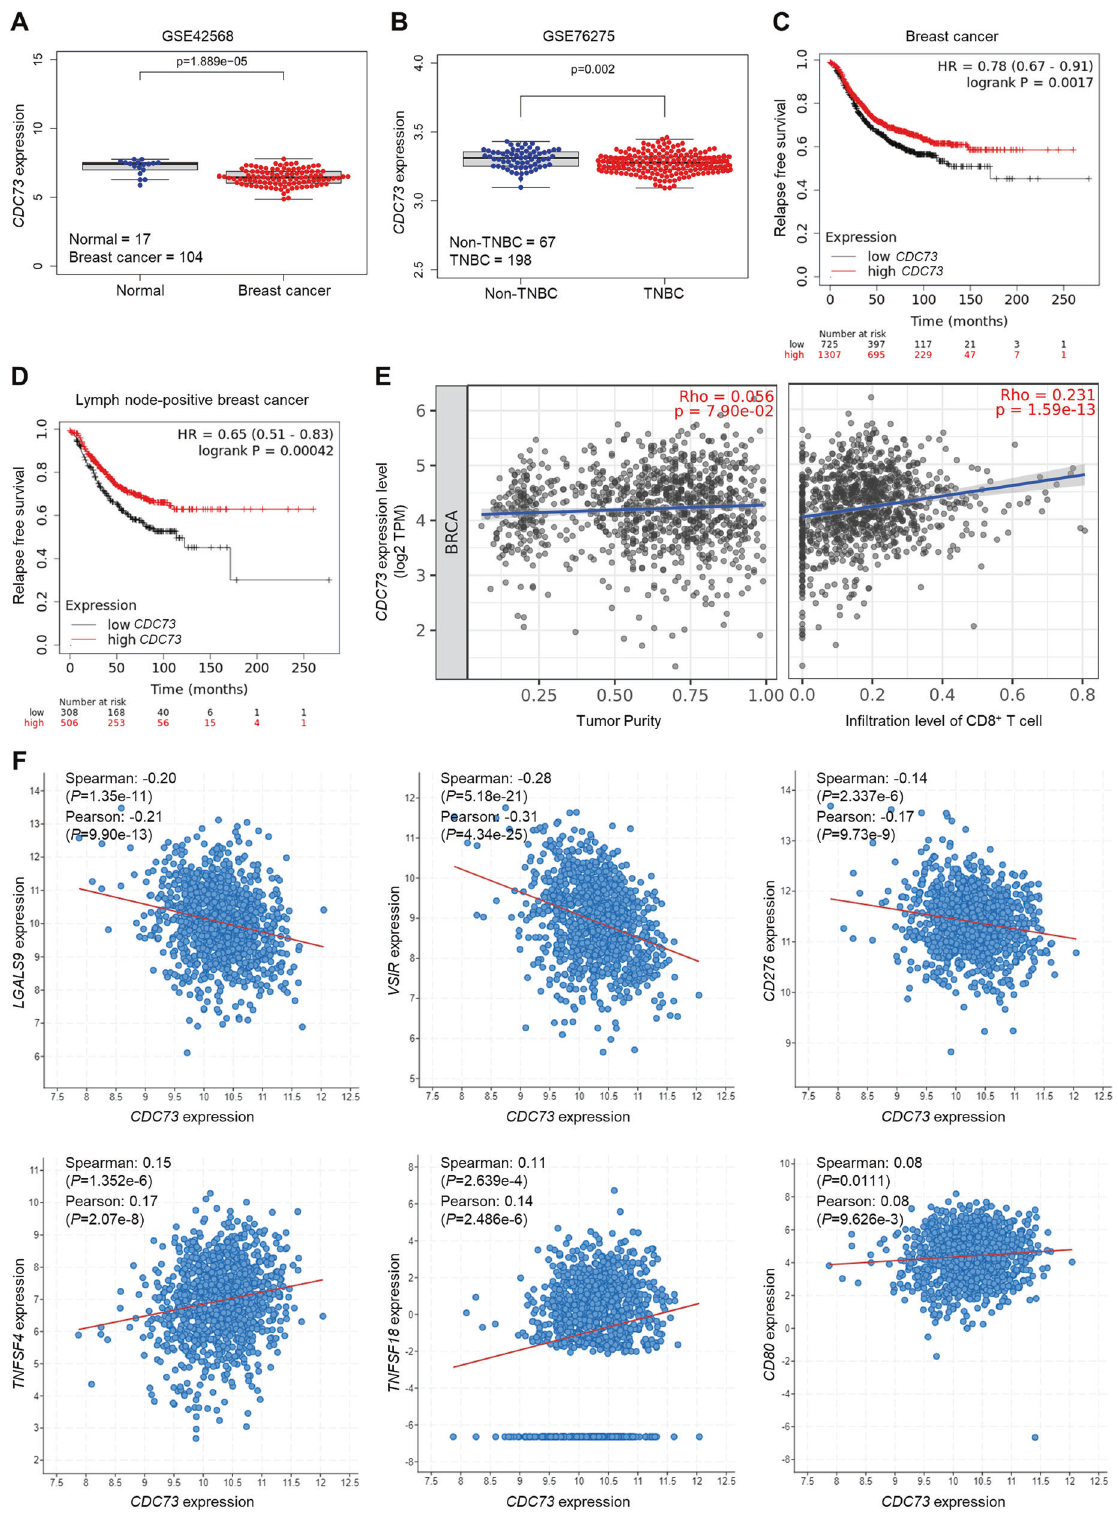
Fig. 1 Expression of CDC73 negatively correlates with human breast cancer progression. A The mRNA level of CDC73 in patient normal breast tissue ( n = 17) and breast cancer tissue ( n = 104) from the subset GSE42568. B The mRNA level of CDC73 in patient Non-TNBC tissue ( n = 67) and TNBC tissue ( n = 198) from the subset GSE76275. Correlations of CDC73 expression with relapse free survival of breast cancer patients ( n = 2032) ( C ) and lymph node-positive breast cancer patients ( n = 814) ( D ) were analyzed by using the Kaplan – Meier plotter database. E Correlations of CDC73 expression with the in fi ltration level of CD8 + T cells (right) in human breast cancer from TCGA BRCA cohort were analyzed by the TIMER2.0 database ( n = 1100). F Correlations of the mRNA expression of CDC73 with the expression of immune response regulators LGALS9 , VSIR , CD276 , TNFSF4 , TNFSF18 , and CD80 in human breast cancer from TCGA were analyzed by using the cBioPortal database ( n = 1084). Cell Death and Disease (2022)